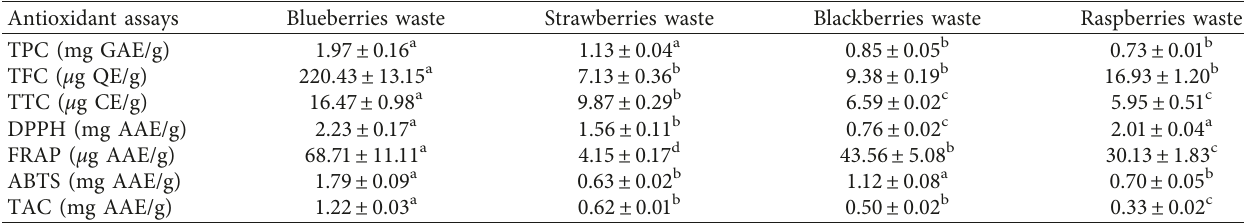
Table 1: Estimation of phenolic content and antioxidant activity present in berries waste. Antioxidant assays